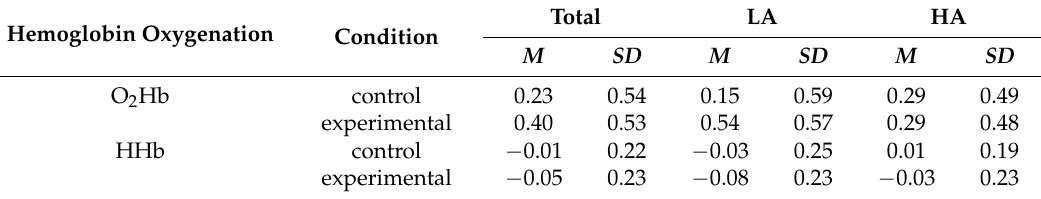
Table 1. Mean ( M ) and standard deviation ( SD ) of oxygenated (O 2 Hb) and deoxygenated (HHb) hemoglobin concentration changes as a function of functional near-infrared spectroscopy (NIRS) condition (control and experimental) for the total sample (Total, N = 42) as well as for the lower (LA, n = 18) and higher (HA, n = 24) mental ability